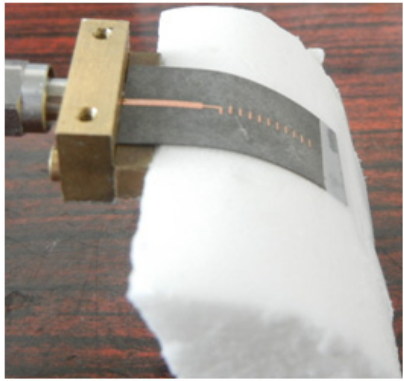
Figure 3. Bending antenna in H -plane on a semi-cylindrical skin-equivalent phantom with R = 15